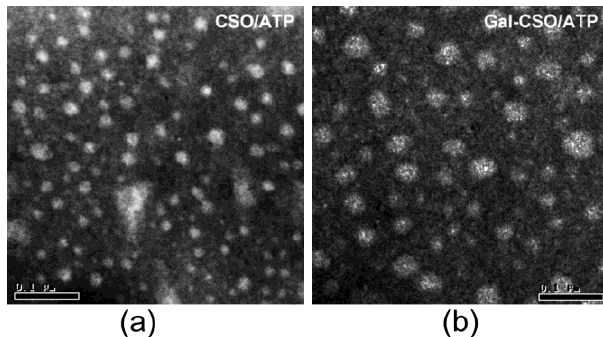
Table 1. Physicochemical characteristics of ATP loaded nanoparticles. Data represent the